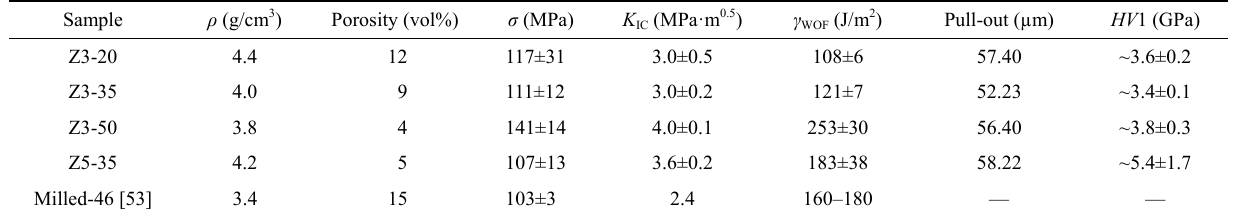
Fig. 7 Surface morphologies of sample Z3-20 in (a) X – Y plane and (b) X – Z plane; sample Z3-35 in (c) X – Y plane and (d) X – Z plane; sample Z3-50 in (e) X – Y plane and (f) X – Z plane; and sample Z5-35 in (g) X – Y plane and (h) X – Z plane. Table 2 Mechanical properties of samples studied in this paper and a reference material with milled fibres, labelled as